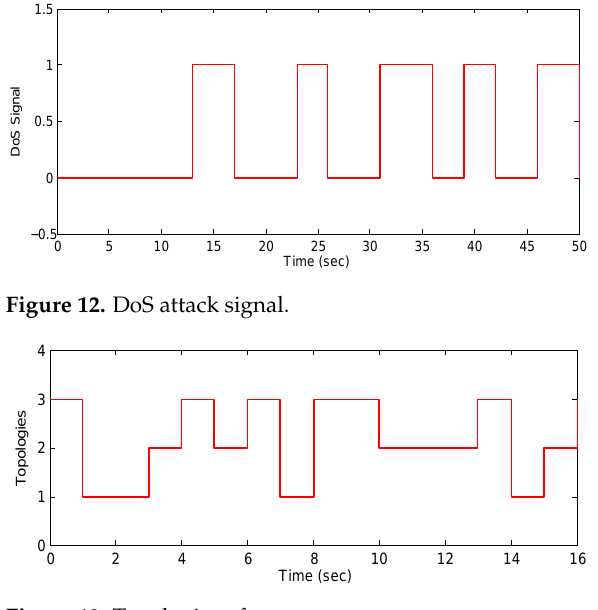
Figure 13. Topologies of systems.